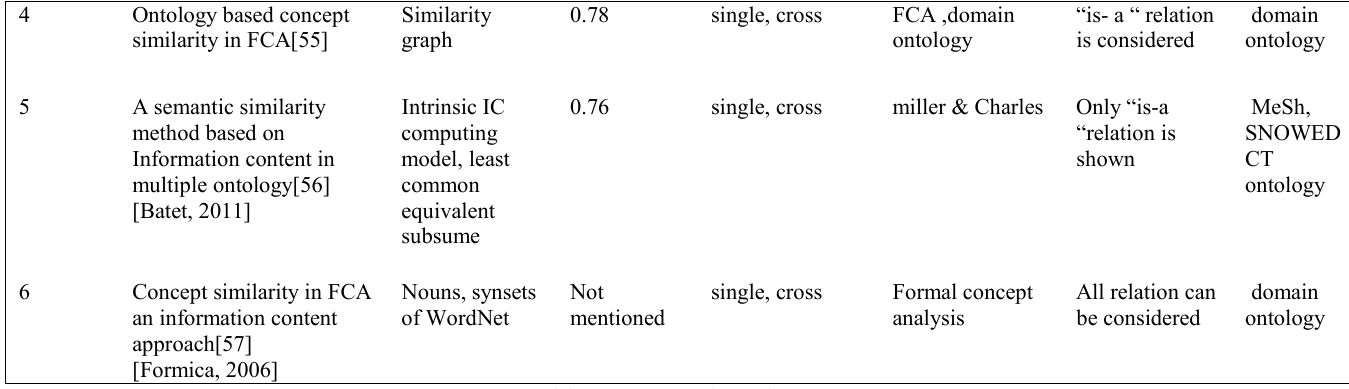
Table 4. Feature based Measures